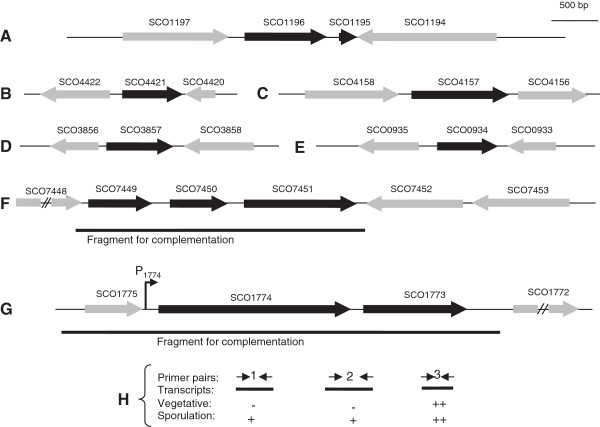
Gene organization along the chromosome of S. coelicolor for the seven new sporulation loci that are described in this paper. (A-G) Genes for which deletion mutants have been constructed are drawn in black. The immediately surrounding genes are shown in grey. DNA fragments used for complementation of deletion mutants are indicated by a line for loci SCO7449-7451(F) and SCO1774-1773(G). For the SCO1774-1773 locus, the results of a semi-quantitative RT-PCR assay are summarized (H). The data are shown in Additional file
2: Figure S5. The presence of different kinds of transcripts in strain M145 is indicated for RNA prepared from vegetative and sporulating mycelium (H). The primer pairs used for RT-PCR (specified in Additional file
1: Table S1) are designated 1, 2, 3, and drawn as arrows. Detection of a transcript is indicated with a plus (+) and the absence with a minus (-). The relative amount of the PCR product is indicated by one or two plus signs. The indicated sporulation induced P1774 promoter (G) was identified by S1 nuclease mapping (see Figure 
6A).